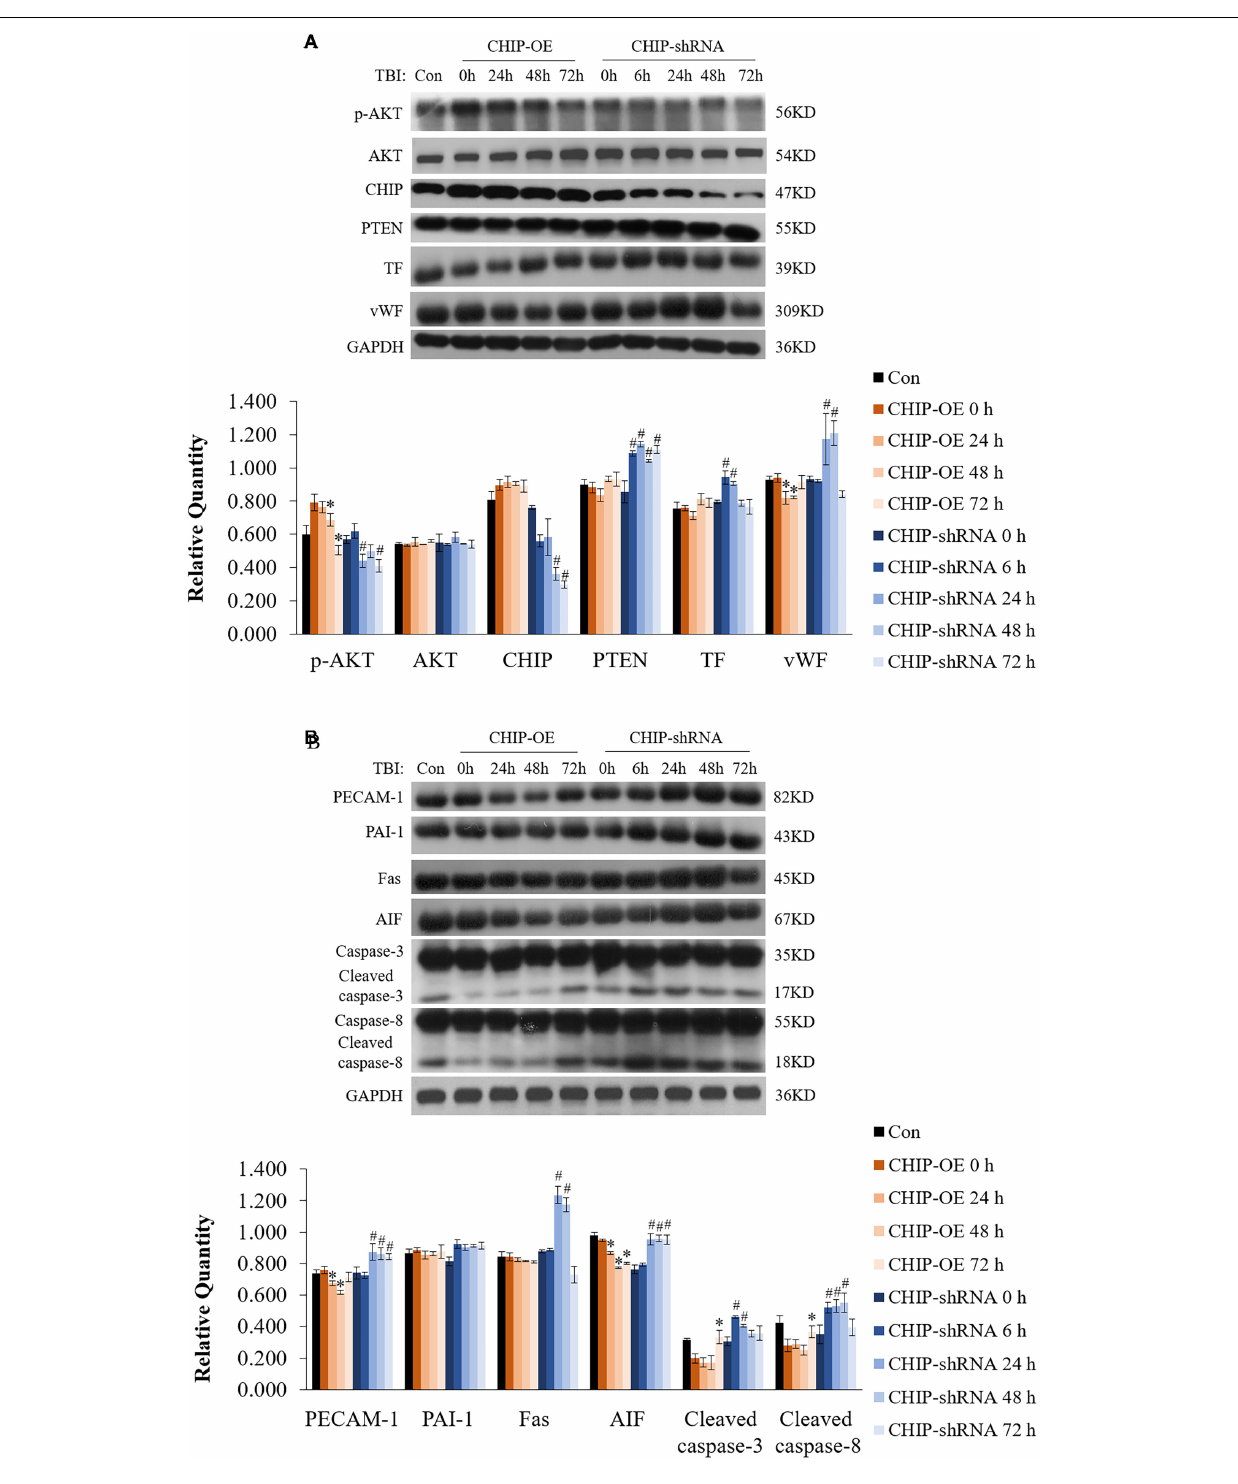
Frontiers in Neuroscience |